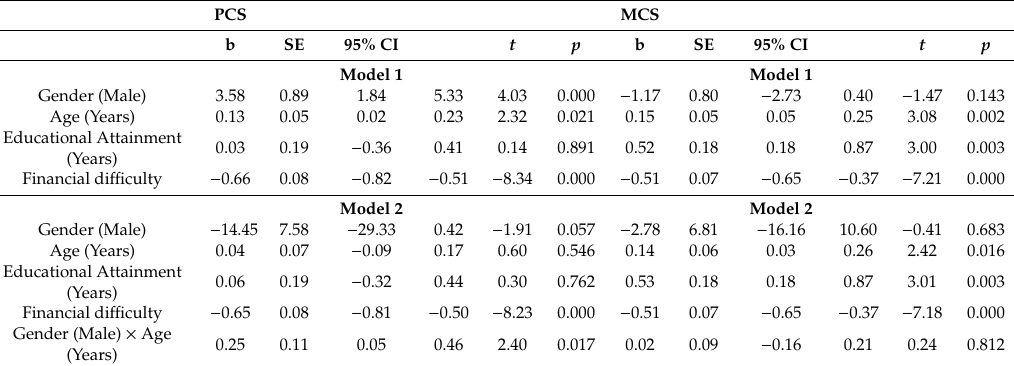
Table 3. Summary of linear regressions with PCS and MCS as the